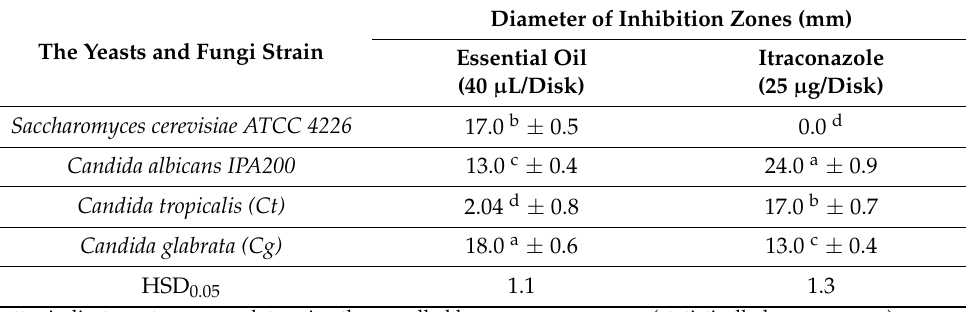
Table 14. Antimicrobial (yeasts and fungi) activity of the essential oil using disc diffusion.